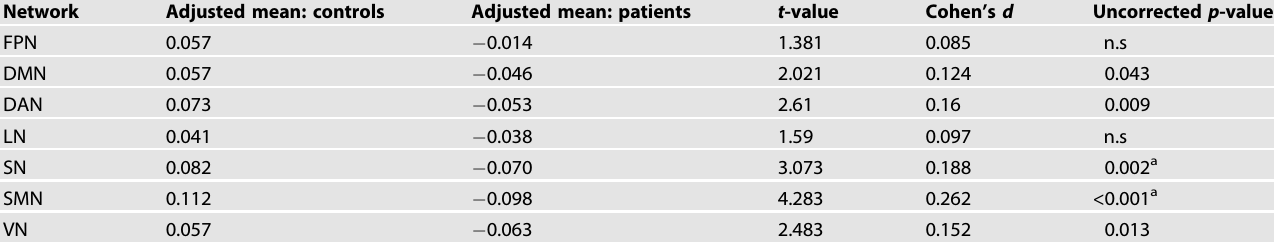
The means of averaged FCs for each group (adjusted for age, gender, mean frame-wise displacement, site), t -values, Cohen ’ s d and uncorrected p -values of FCs are reported for the comparison between patients and healthy subjects at the network level. FPN frontoparietal network, DMN default mode network, DAN dorsal attention network, LN limbic network, SN salience network, SMN somatosensory motor network, VN visual network. a Signi fi cant p -value after Bonferroni correction for multiple